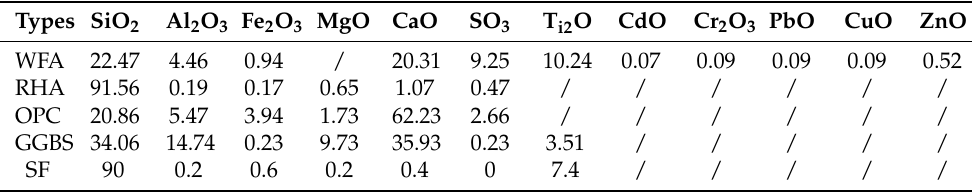
Table 1. Chemical composition of the cementitious materials/%.